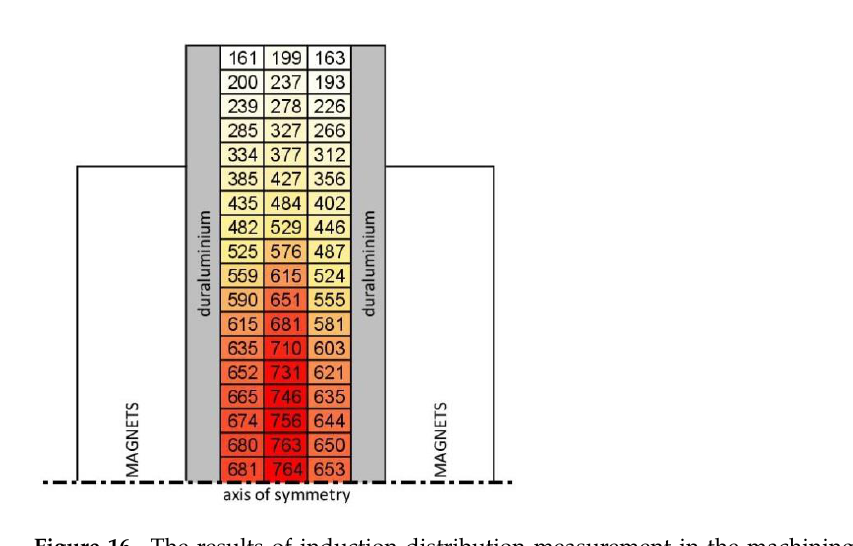
Figure 17. The results of induction distribution measurement in the machining gap [×10 −3 T]. The distance between magnets amounts to 33 mm.